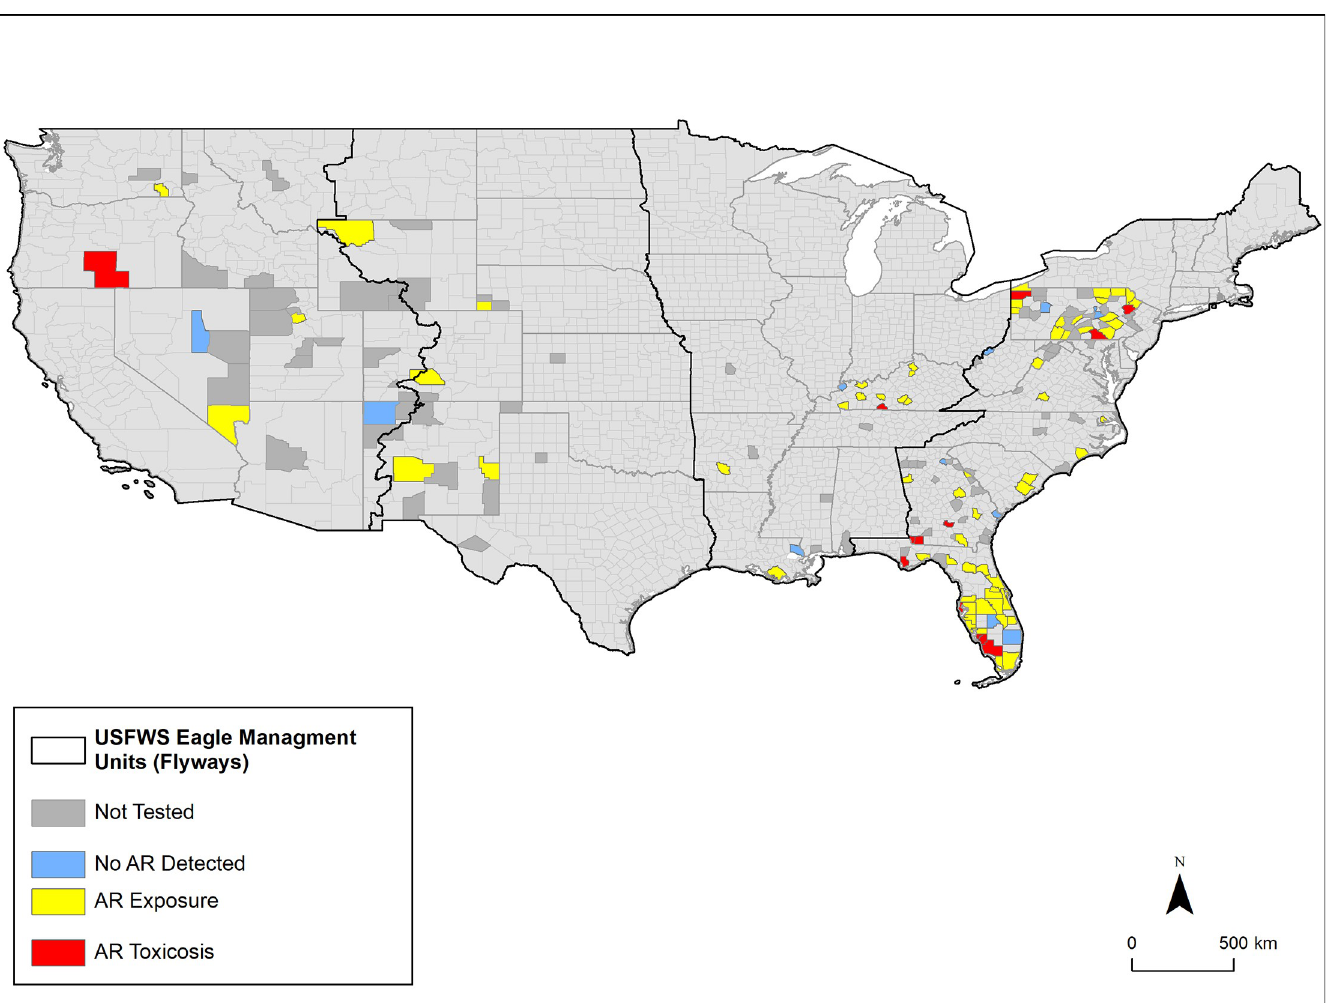
Fig 1. The geographic distribution of eagles submitted for postmortem examination to the Southeastern Cooperative Wildlife Disease Study, 2014–2018. Highlighted are counties dead eagles were received; and which eagles were not tested for AR (dark gray), no AR was detected (blue), AR exposure documented (yellow), or AR toxicosis confirmed (red). One eagle submitted from Matanuska Susitna County, Alaska is not shown and had no ARs detected. Black lines represent United States Fish and Wildlife Service Eagle Management Units, designated by the United States Migratory Bird